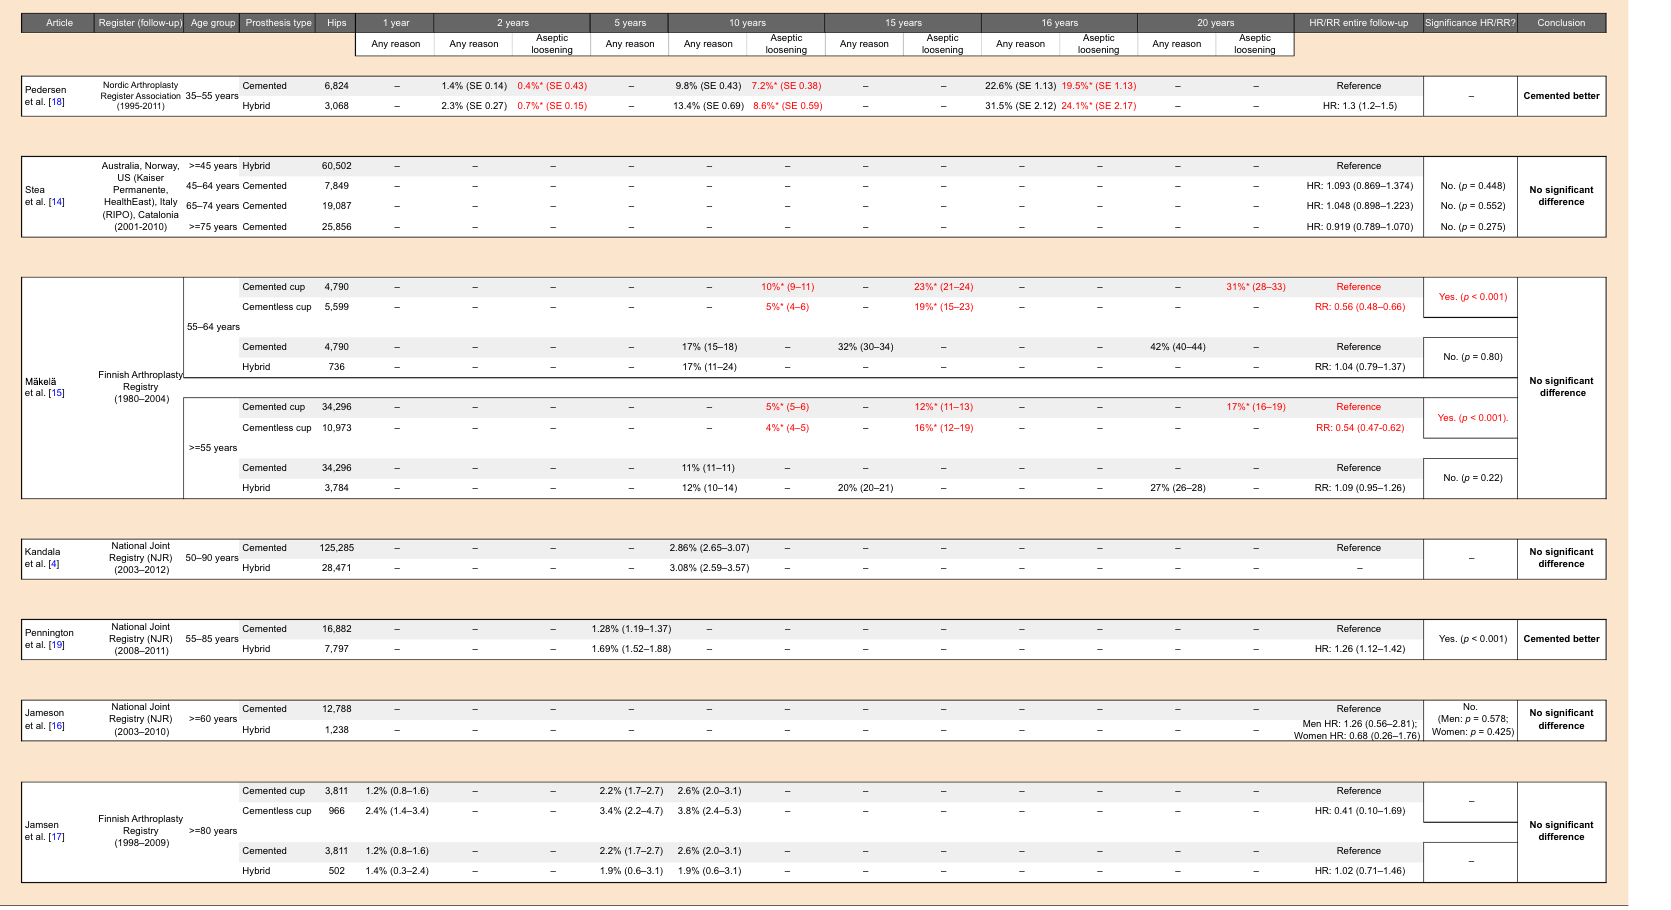
Grey-coloured cells were used as a reference in risk calculations. 95% con fi dence intervals are shown between brackets ( – = not reported; * = revision for aseptic loosening, coloured red. CI, con fi dence interval; SE, standard error; HR, hazard ratio; RR, relative